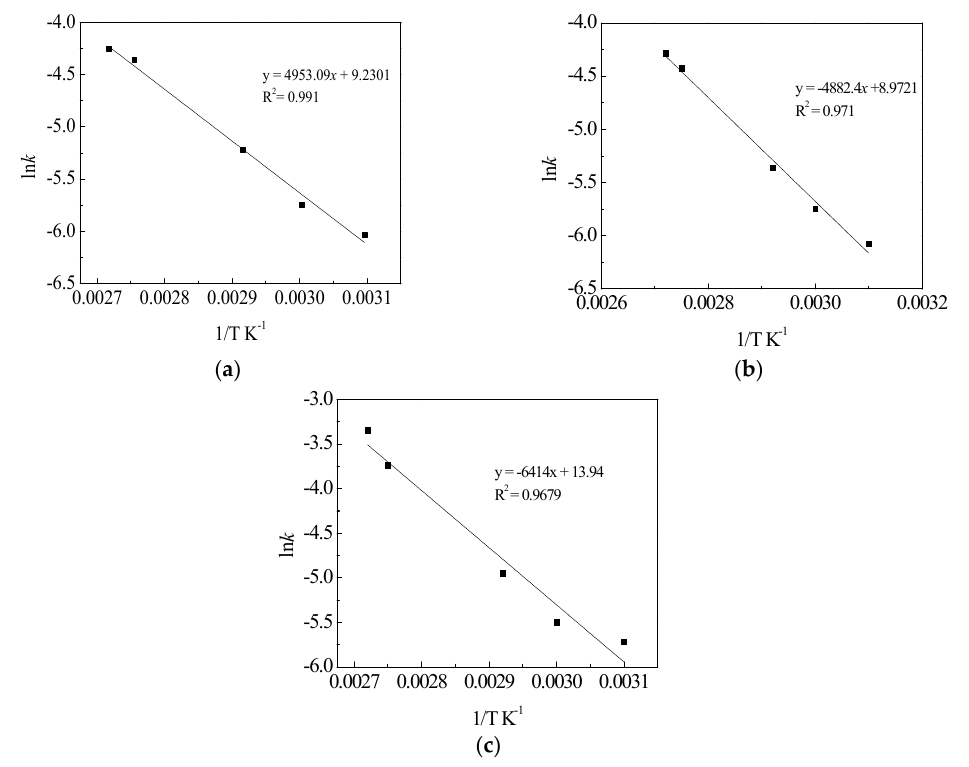
Figure 10. Plots of lnk versus reciprocal temperature of leaching TMn ( a ); MnO 2 ( b ); and MnCO 3 ( c ) in semi-oxidized manganese ore.